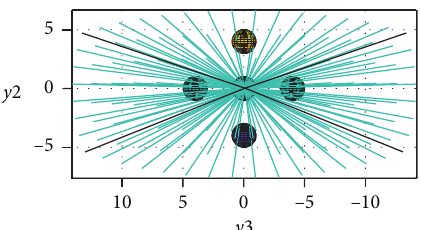
Figure 14: Front projection of the 3D lidar’s view for five scattered obstacles in 15